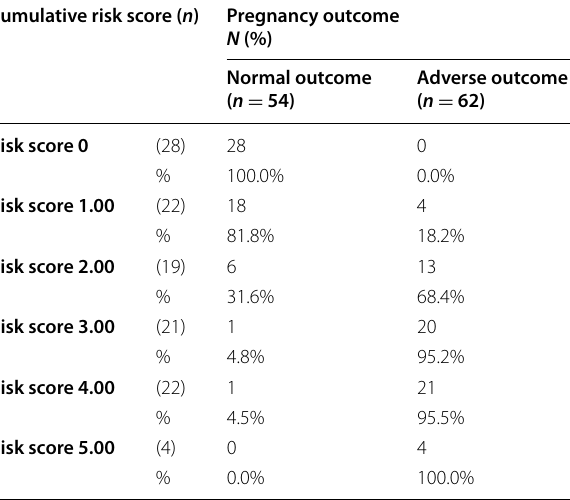
Table 8 The adverse pregnancy outcome of lupus patients based on their cumulative risk